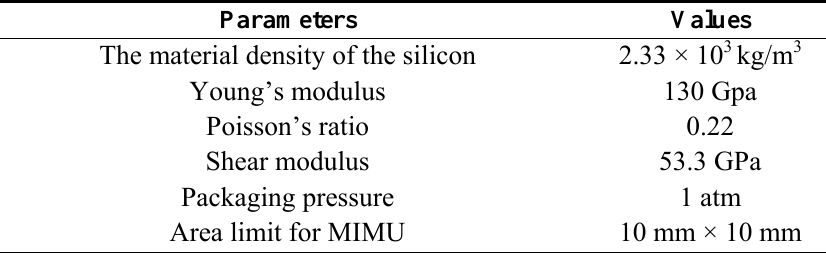
Table 3. The common parameters for MIMU